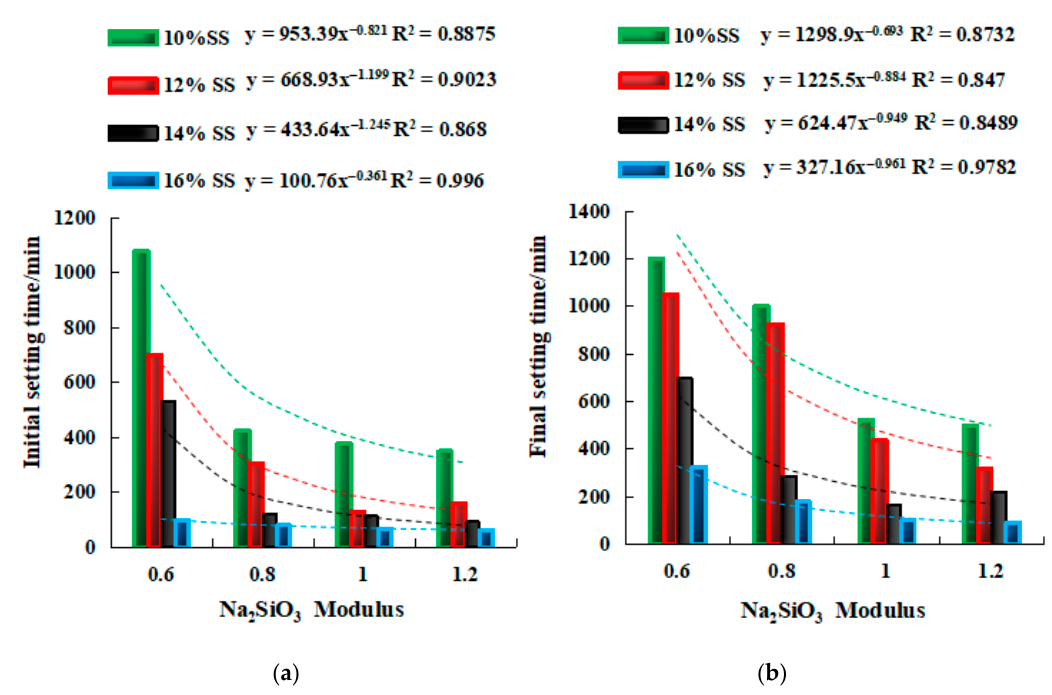
Figure 6. The relationship of setting time and modulus. ( a ) Initial setting time. ( b ) Final setting time. y = ax 2 + bx + c, where y is the setting time, min. x is the Na 2 SiO 3 modulus, 0.6 ≤ x ≤ 1.2. a, b, and c are constants.